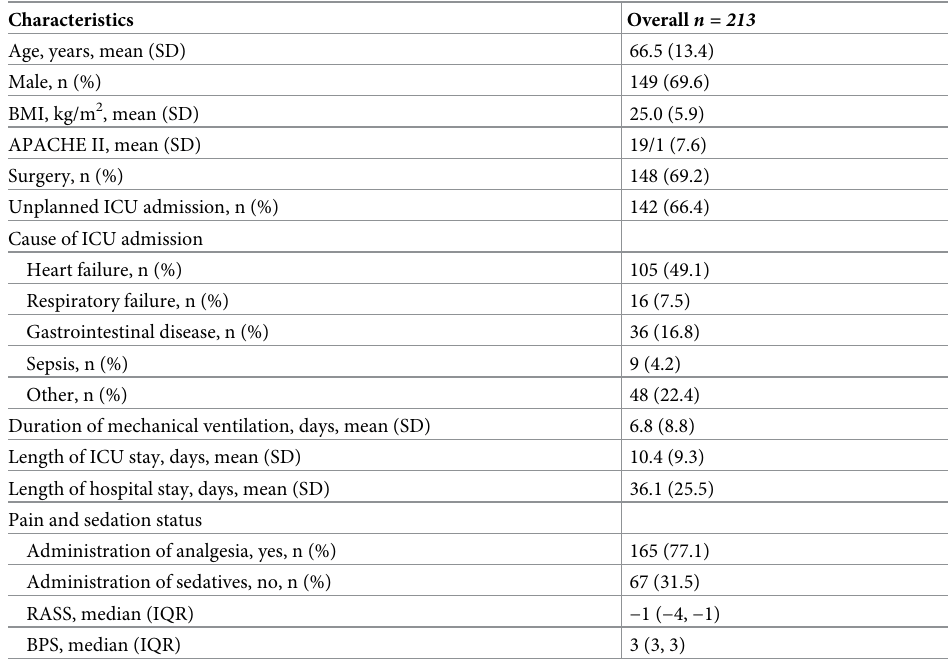
Table 1. Characteristics of 213 observations in critically ill ventilated patients.